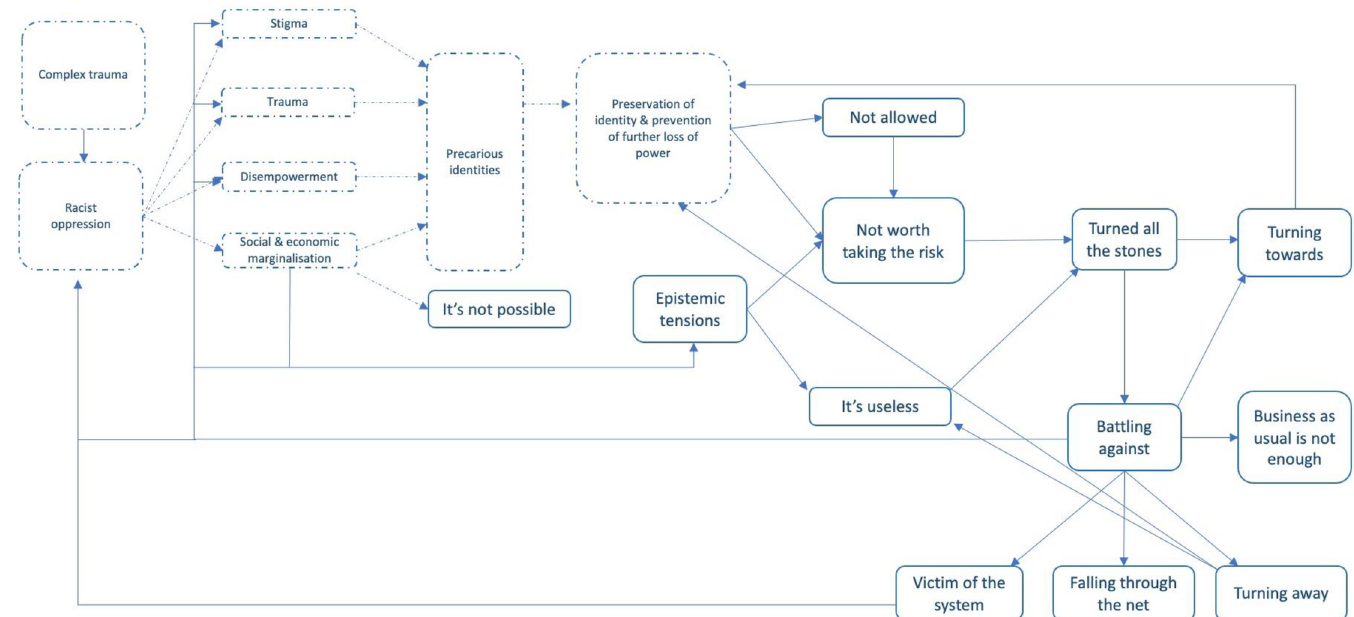
Fig 2. Line of argument synthesis. Dotted lines used to distinguish social determinants and processes from key metaphors (boxes with solid lines).